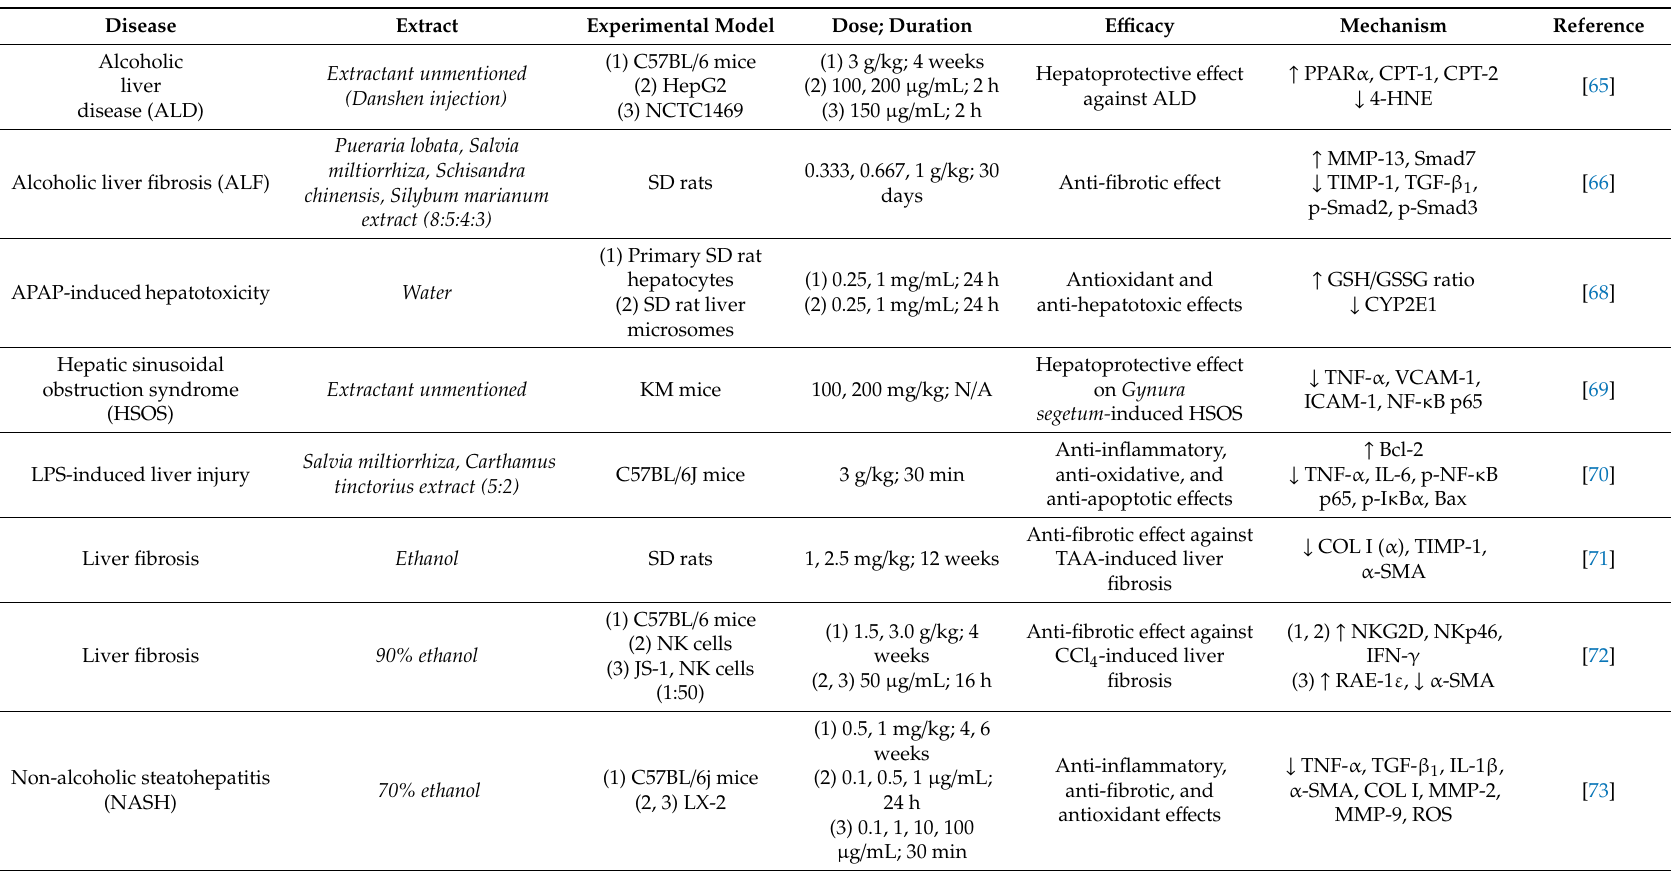
Table 3. Liver diseases and S.